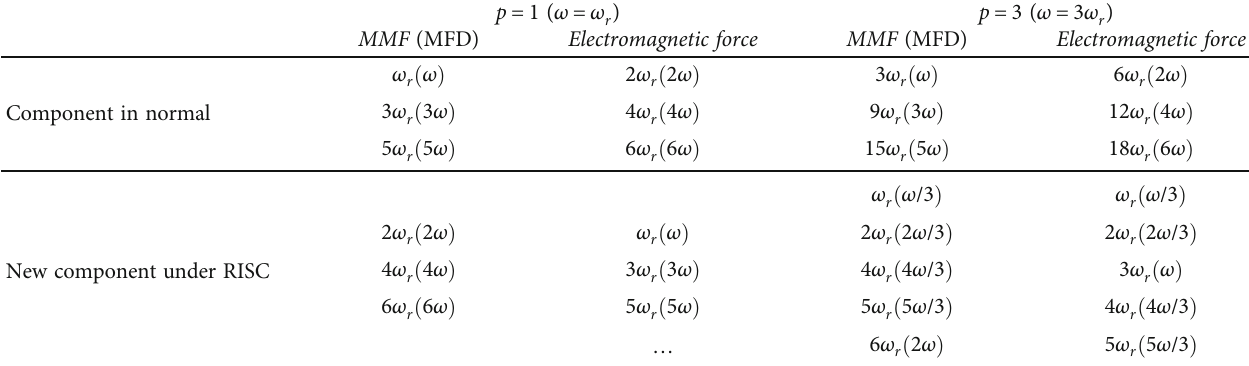
Table 1: Component comparison of MMF and electromagnetic